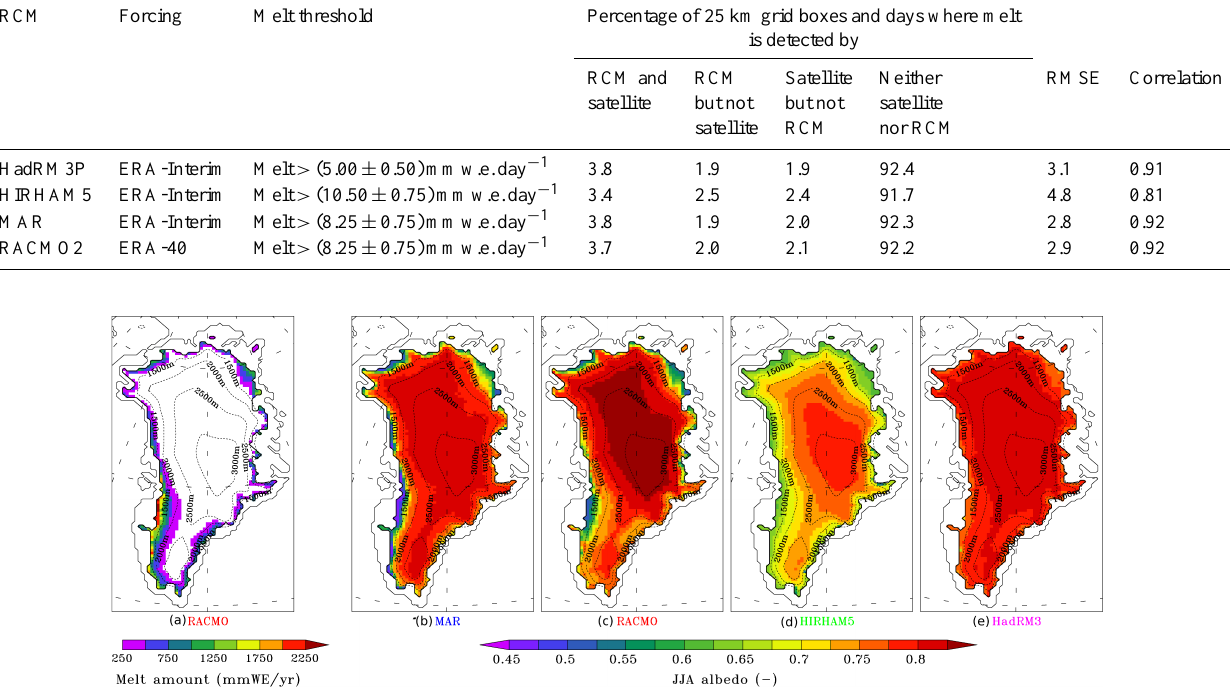
Fig. 4. (a) 20-yr (1989–2008) mean summer meltwater production in mmw.e. per summer, simulated by RACMO2 over 1989–2008. (b) – (e) 1989–2008 mean July albedo simulated by (b) MAR, (c) RACMO2, (d) HIRHAM5 and (e) HadRM3P. The monthly mean July albedo is shown here because the minimum of albedo occurs during this month, corresponding to the maximum extent of the bare ice